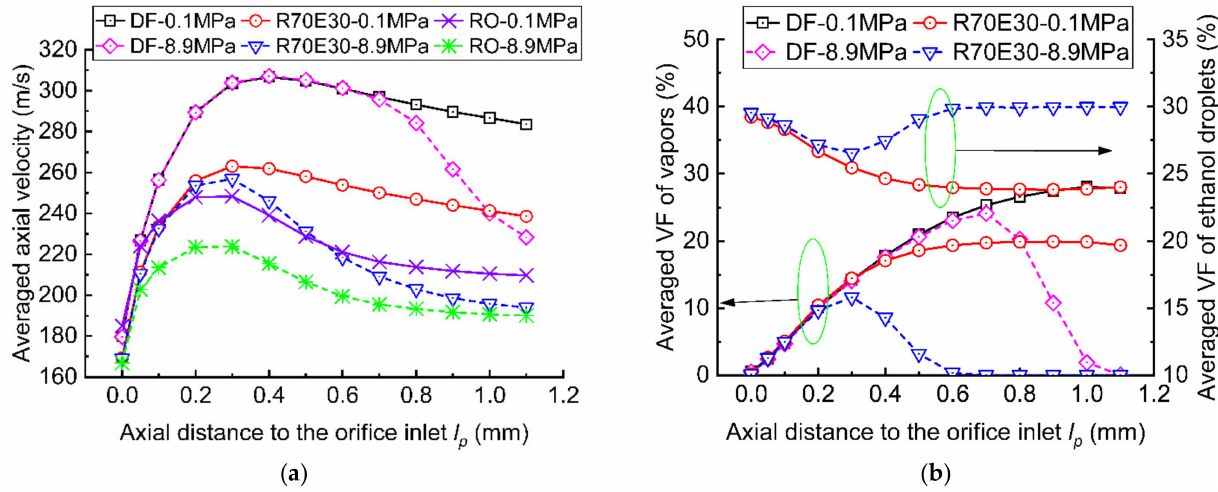
Figure 11. Change of axial velocity ( a ) and phase VF ( b ) of DF, RO, and R70E30 averaged over the cross-section of the nozzle hole along the hole axis under backpressures of 0.1 and 8.9 MPa.